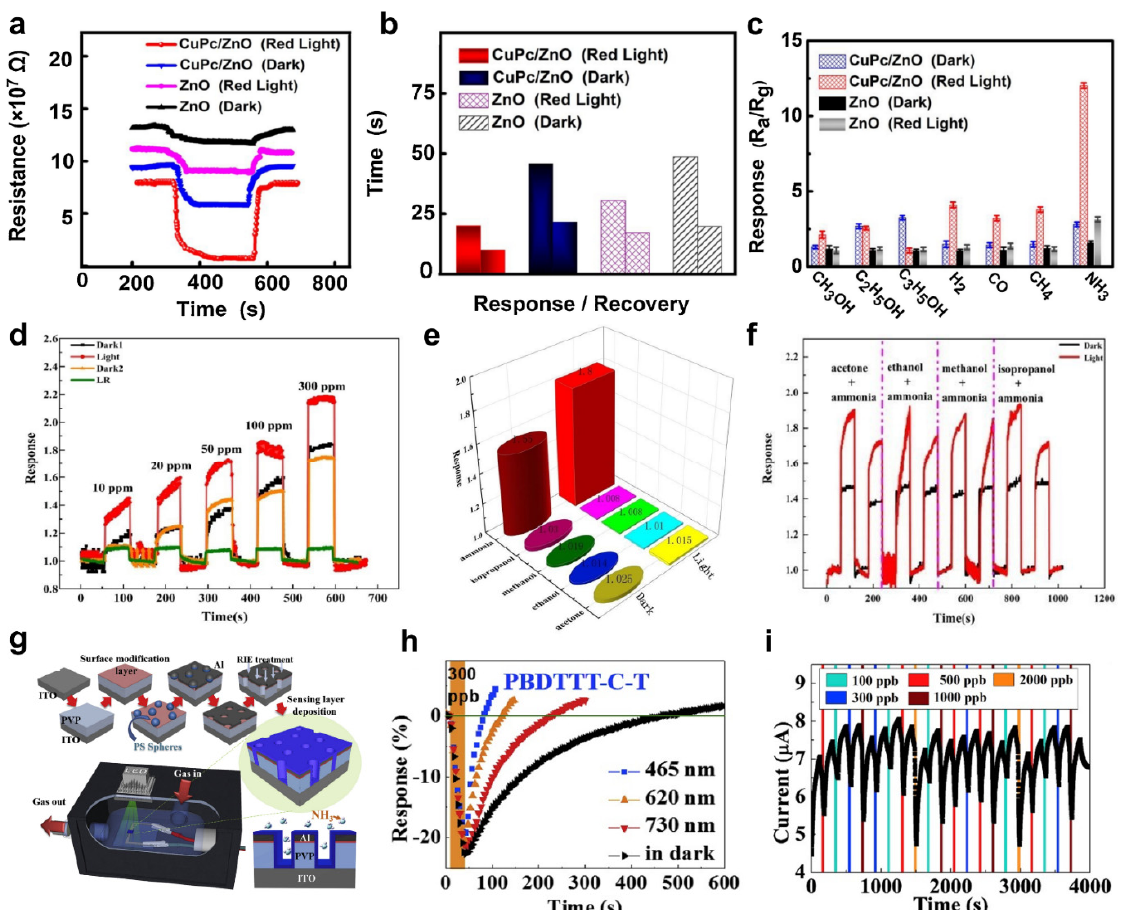
Figure 9. ( a ) Response of the CuPc/ZnO gas sensor and the pure ZnO gas sensor in dark and under red light irradiation; ( b ) response and recovery time of the CuPc/ZnO gas sensor and the pure ZnO gas sensor under dark and red light irradiation; ( c ) selectivity characteristics of the CuPc/ZnO gas sensor (adapted from [104] with permission from the Elsevier B.V.); ( d ) response of the Ag 3 PO 4 NPs gas sensor; ( e ) selectivity characteristics of the Ag 3 PO 4 NPs gas sensor; ( f ) response of the mixed NH 3 –based gas (adapted from [105] with permission from the John Wiley and Sons); ( g ) fabrication process of the PBDTTT − C − T gas sensor and the NH 3 gas detection system; ( h ) response of the PBDTTT − C − T gas sensor; ( i ) stability of the PBDTTT − C − T gas sensor (adapted from [106] with permission from the Elsevier B.V.). Table 1. Comparison of sensing performance of the photo − activated gas sensor.